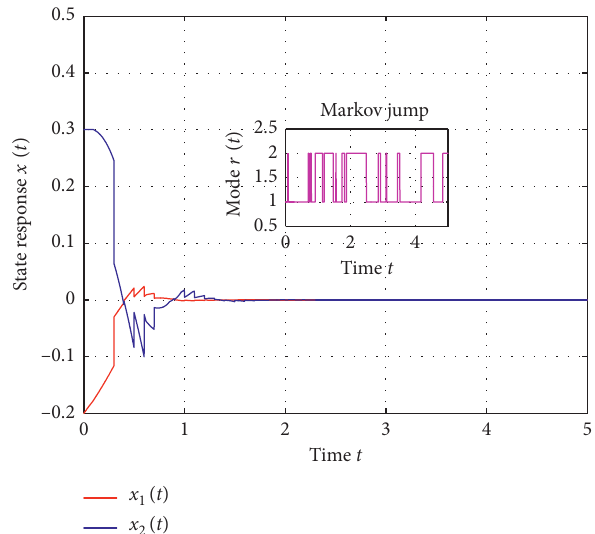
Figure 5: Curve of x ( t ) for Example 1 under